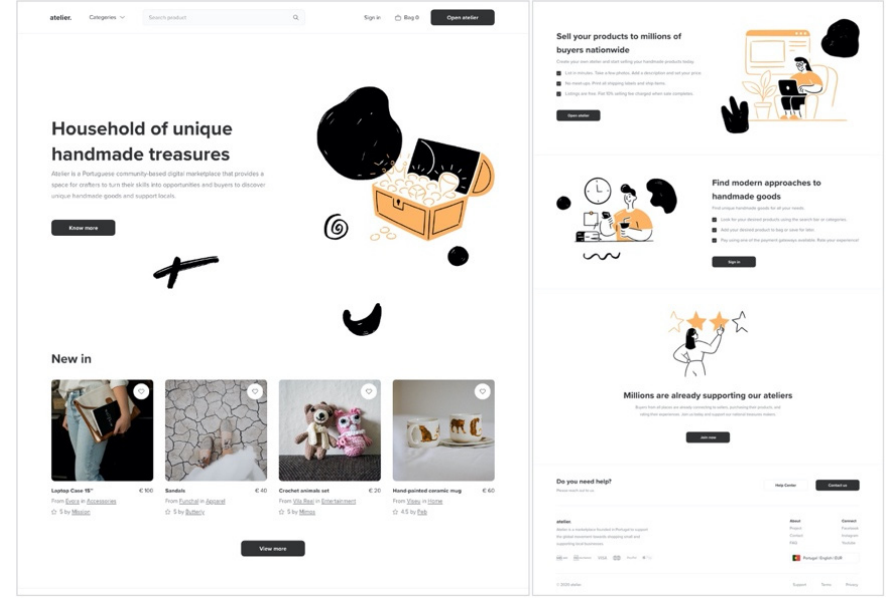
Figure 8. Homepage. Self-source, 2020.